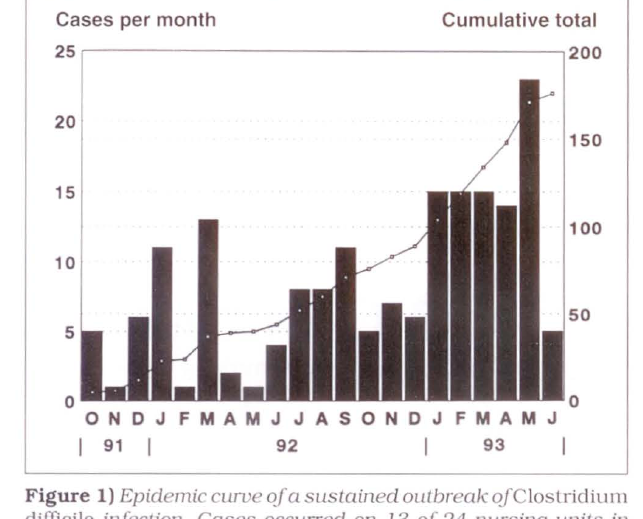
Figure 1) Epidemic cWlJe of a sustained outbreak ojCioslriclium clifficile irifection. Cases occurred on 13 of 24 nursing units in the hospital. More than 65% of cases occurred on a medical Leaching unit. a nonteaching medical unit and a